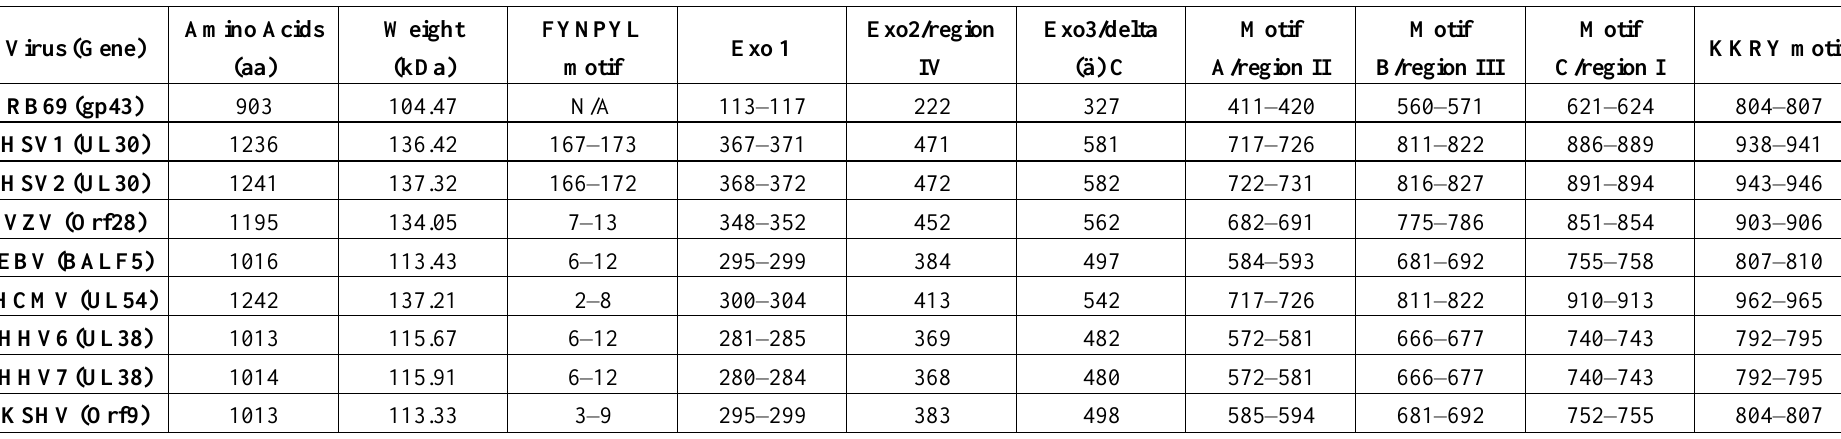
Table 1. Comparison of size, weight and position of conserved motifs or active site residues of RB69 and herpesviridae DNA polymerases. The position conserved motifs where assigned based on alignments generated using geneious